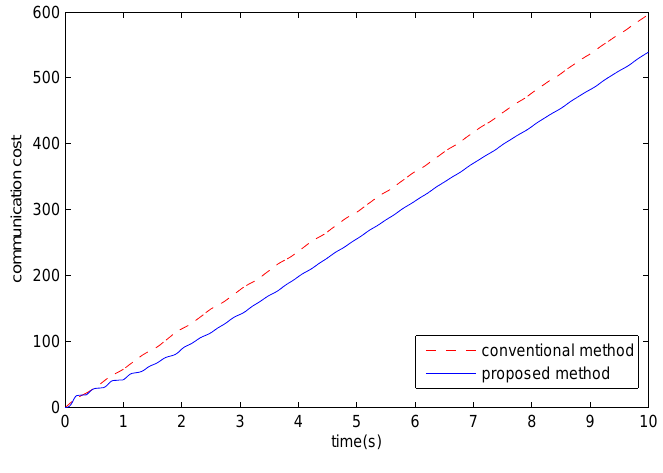
Figure 12. Communication cost comparison.